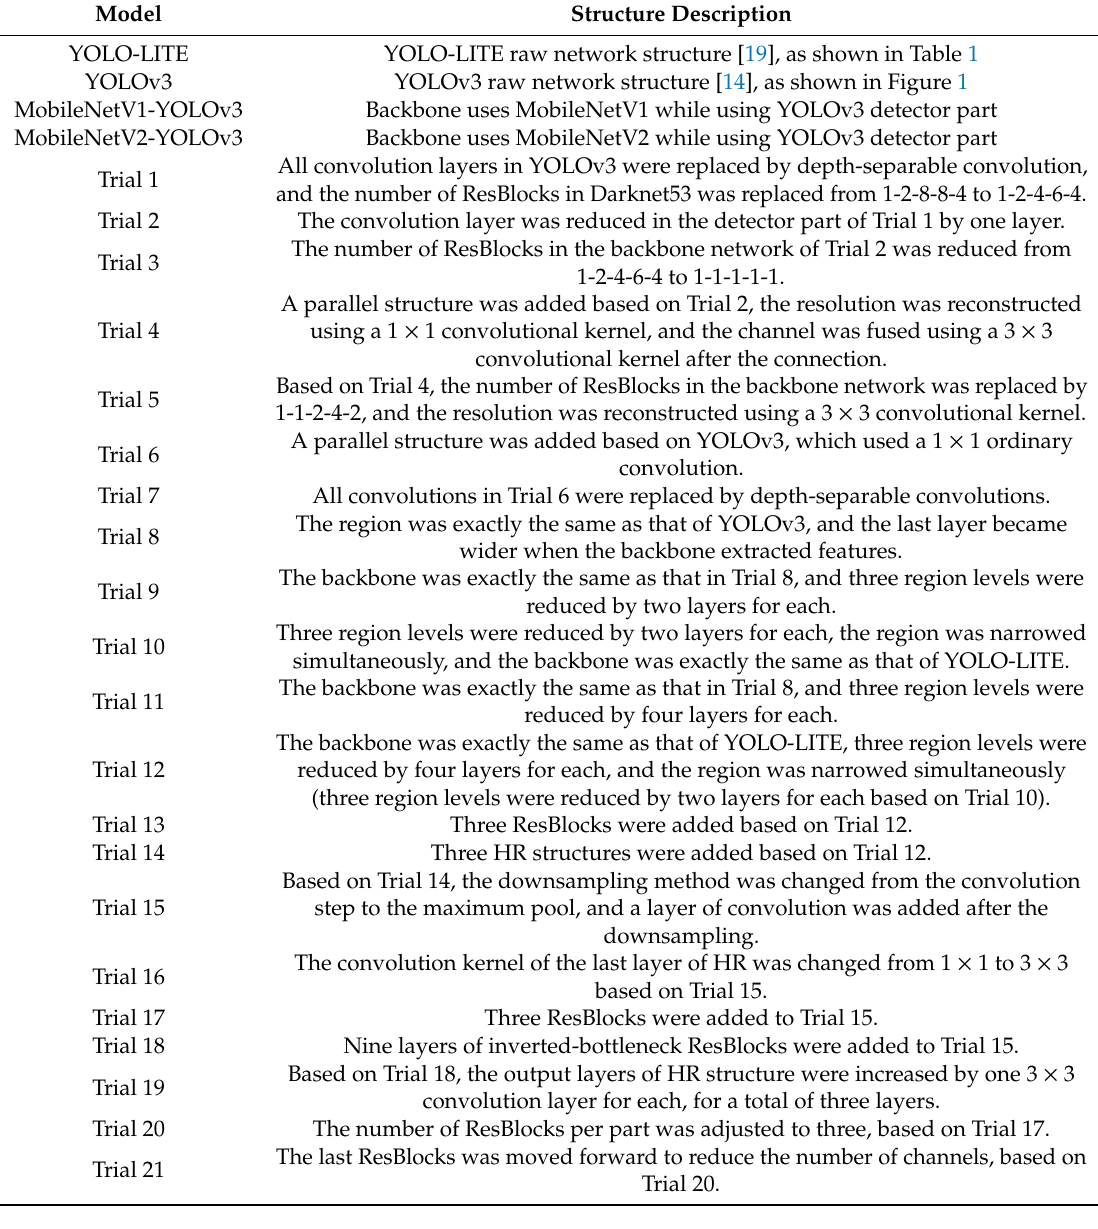
Table 5. Network structure description of di ff erent